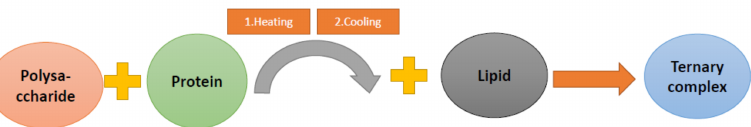
Figure 4. Thermomechanical method for preparation of ternary complex in a Rapid Visco Ana- lyzer